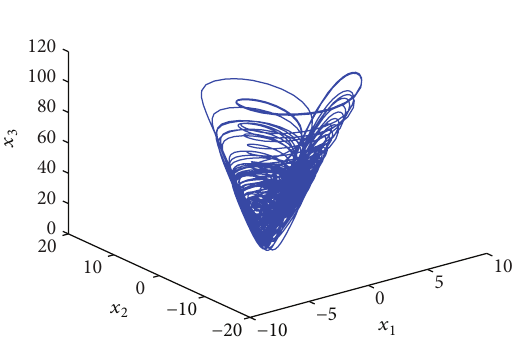
Figure 1: Hyperchaotic attractor of system (2).